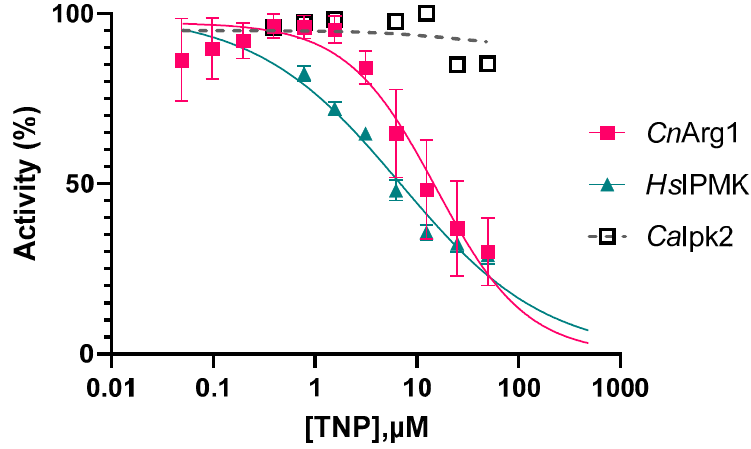
Figure 3. TNP inhibits Cn Arg1 and Hs IPMK but not Ca Ipk2. Reactions were carried out at room